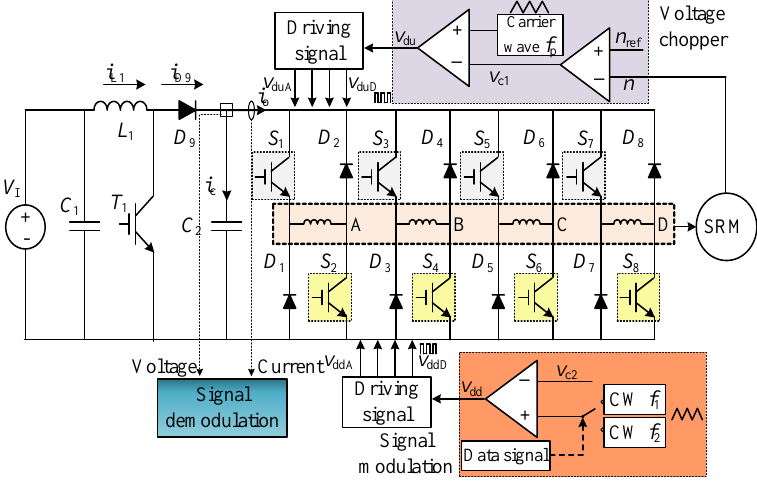
Figure 25. Frequency spectrum with similar frequency. Experimental platform is built according to the simulation model, as shown in Figure 26. Figure 24. Frequency spectrum and demodulated data as the transmission resistance is 4 Ohm.